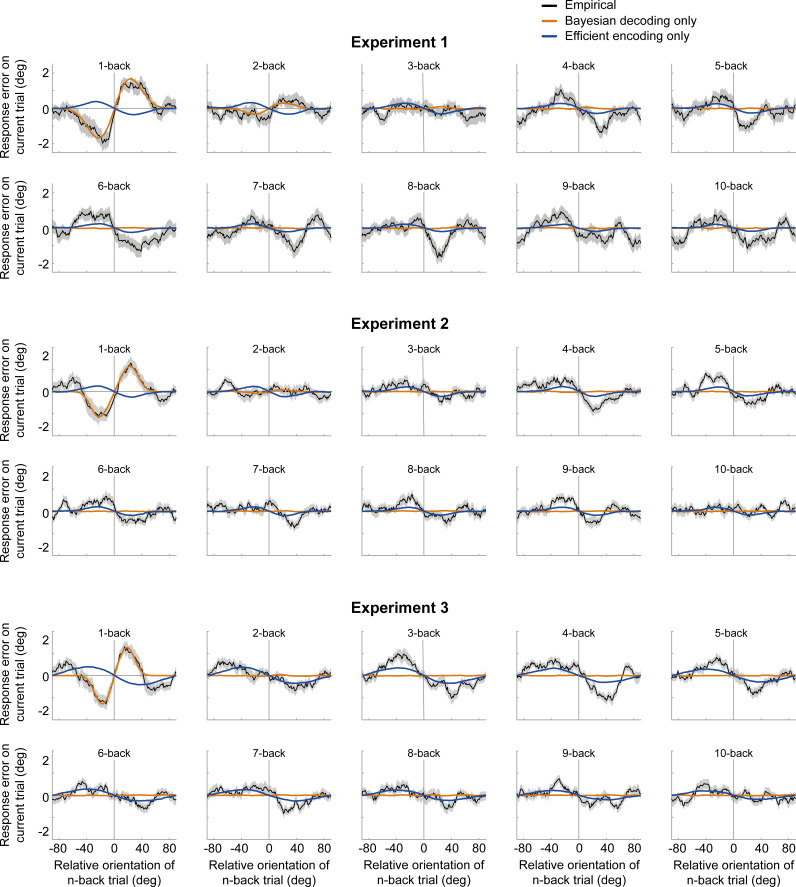
Serial dependence biases of an ideal observer, in which sensory history influenced only Bayesian decoding (orange) or only efficient encoding (blue).Neither of the models can account for both attractive and repulsive biases. While the observer with Bayesian decoding can only produce attraction biases, the observer with efficient encoding only exhibits repulsion. Model biases are computed by simulating the ideal observer model on the stimulus sequences shown to human participants. Human serial dependence biases are shown in black. Shaded regions denote SEMs of the empirical data.